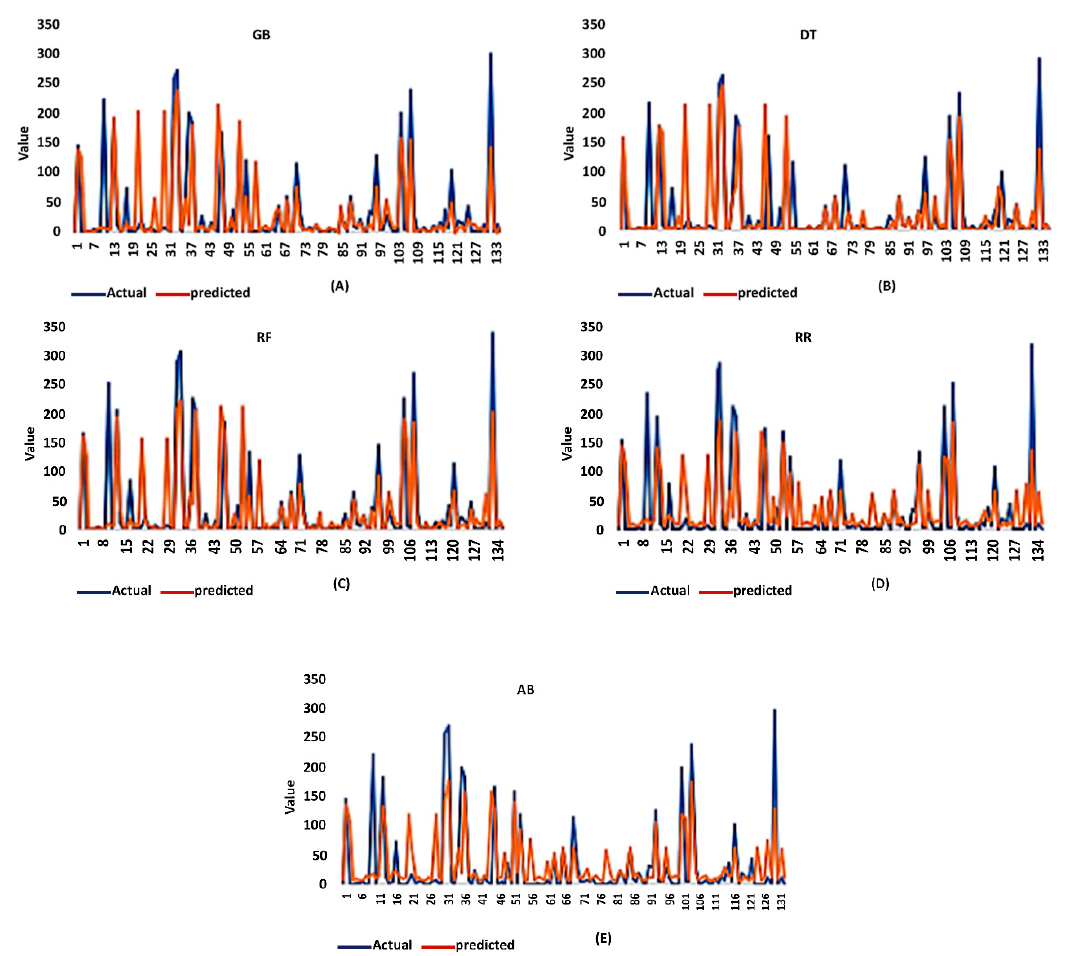
Figure 12. Actual vs. Predicted Values ( A ) GB, ( B ) DT, ( C ) RF, ( D ) RR, and ( E ) AB.